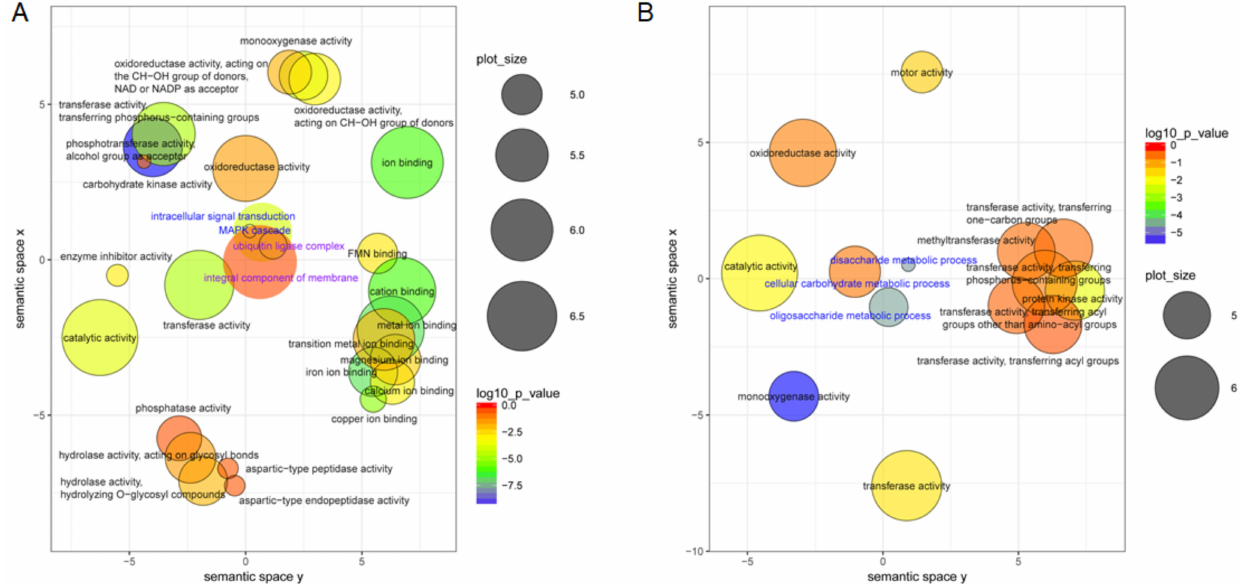
Figure 3. GO enrichment of DEGs of Vitis davidii Föex berries with Colletotrichum viniferum infection at 7 dpi. ( A ) GO enrichment of up-regulated genes; ( B ) GO enrichment of down-regulated